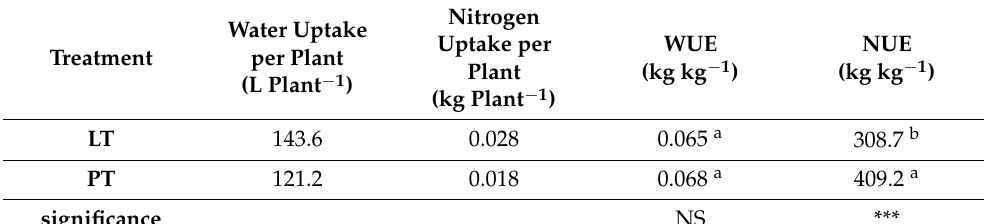
Table 5. Effect of training methods on water and nutrient use efficiency at the end of the experiment (133